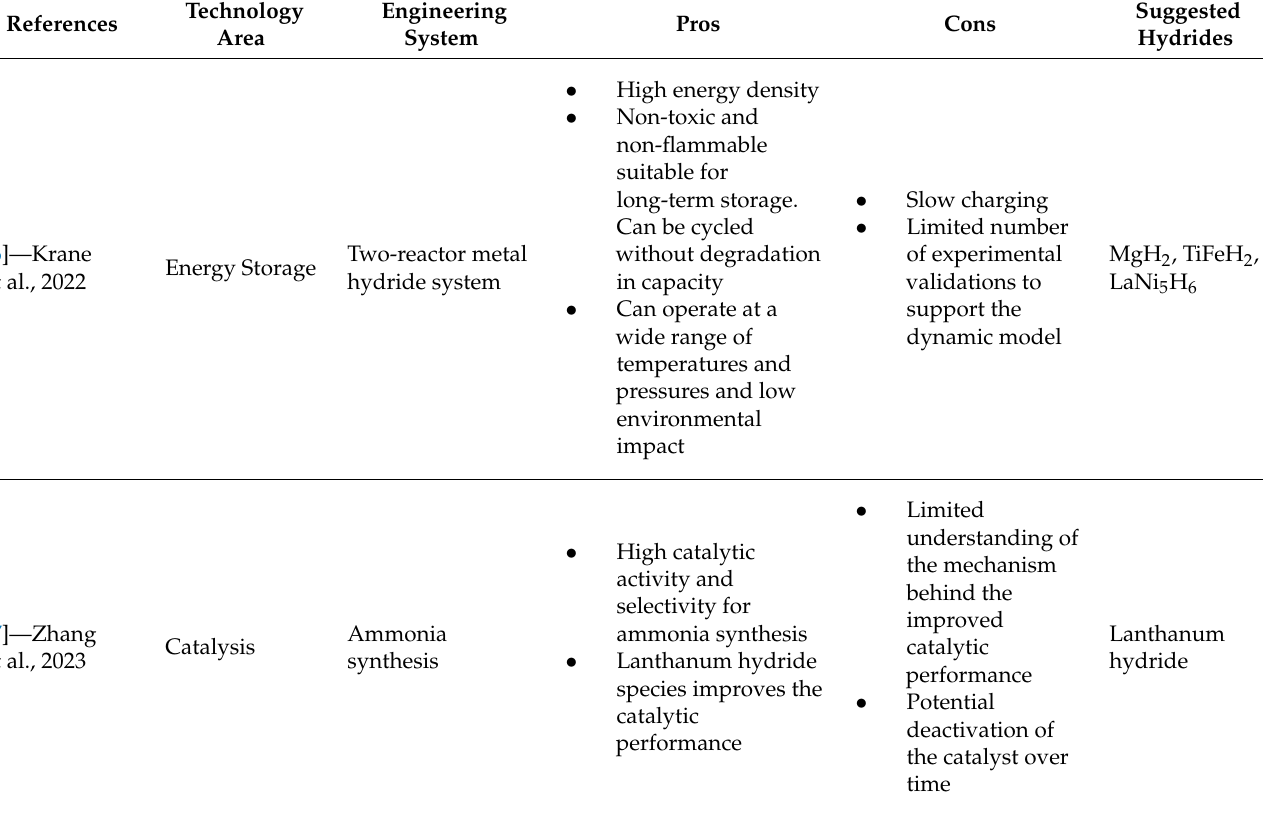
Table 1. Some applications where metal hydrides are